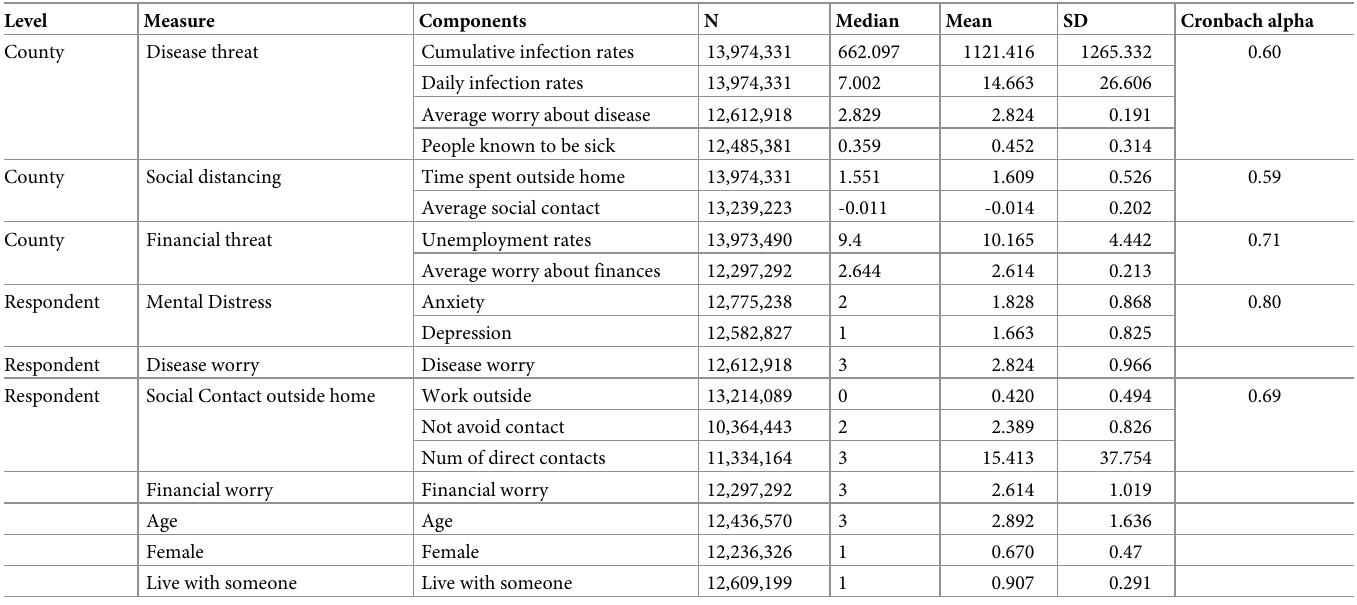
Table 2. Descriptive statistics.